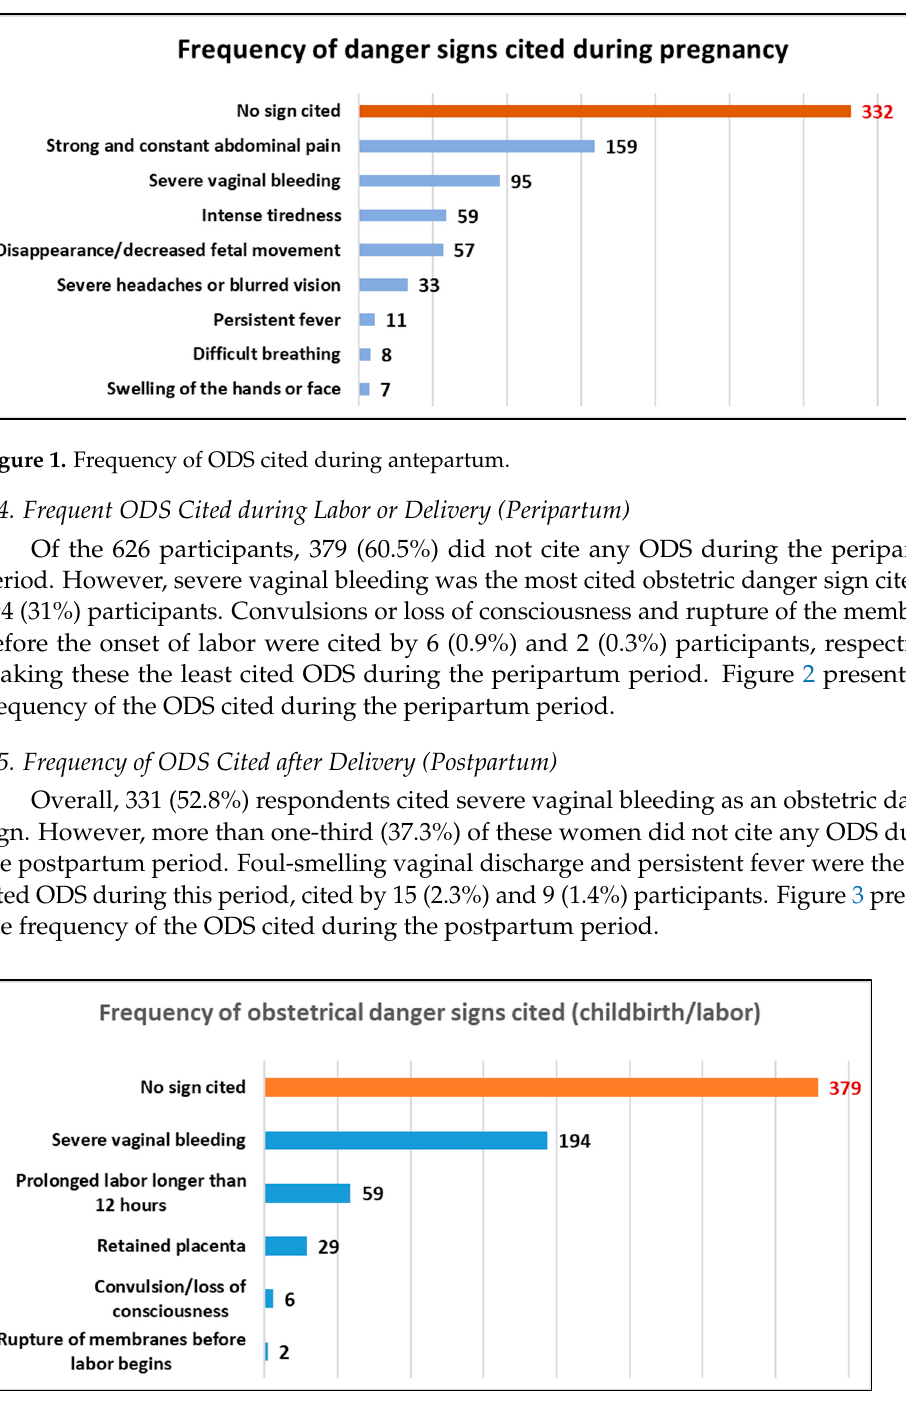
Figure 2. Frequency of ODS cited during peripartum (childbirth/labor).